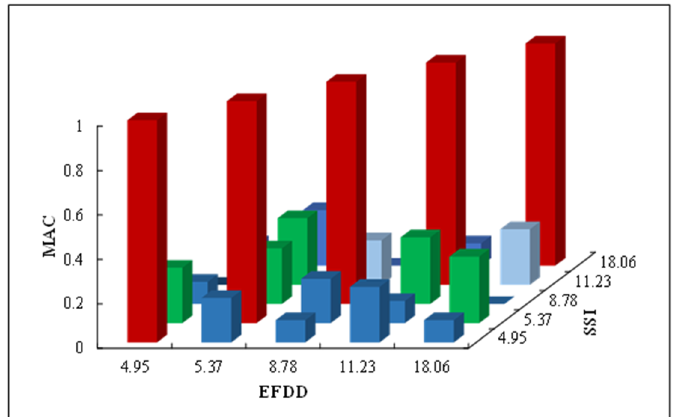
Figure 12. The MAC values between extracted modes through SSI and EFDD techniques.